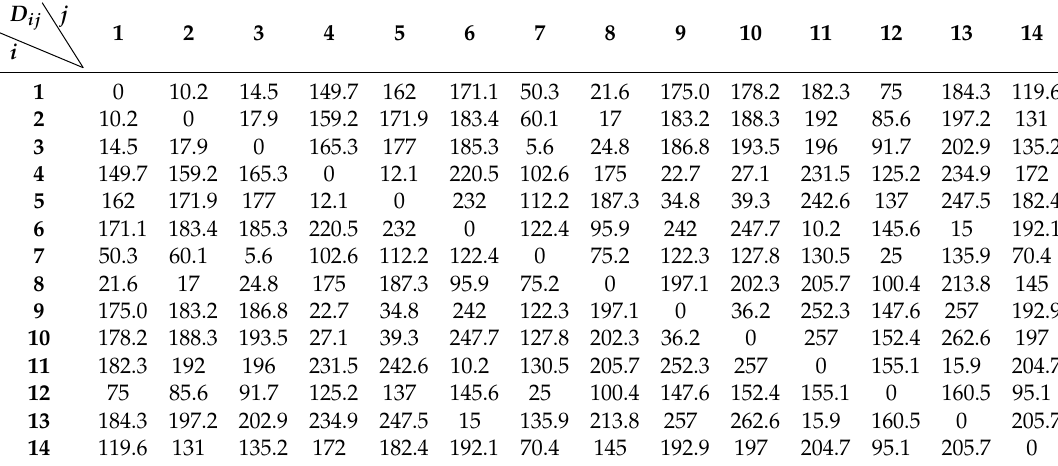
Table A1. Distance matrix of 14 microgrids in the Guizhou Grid (km).